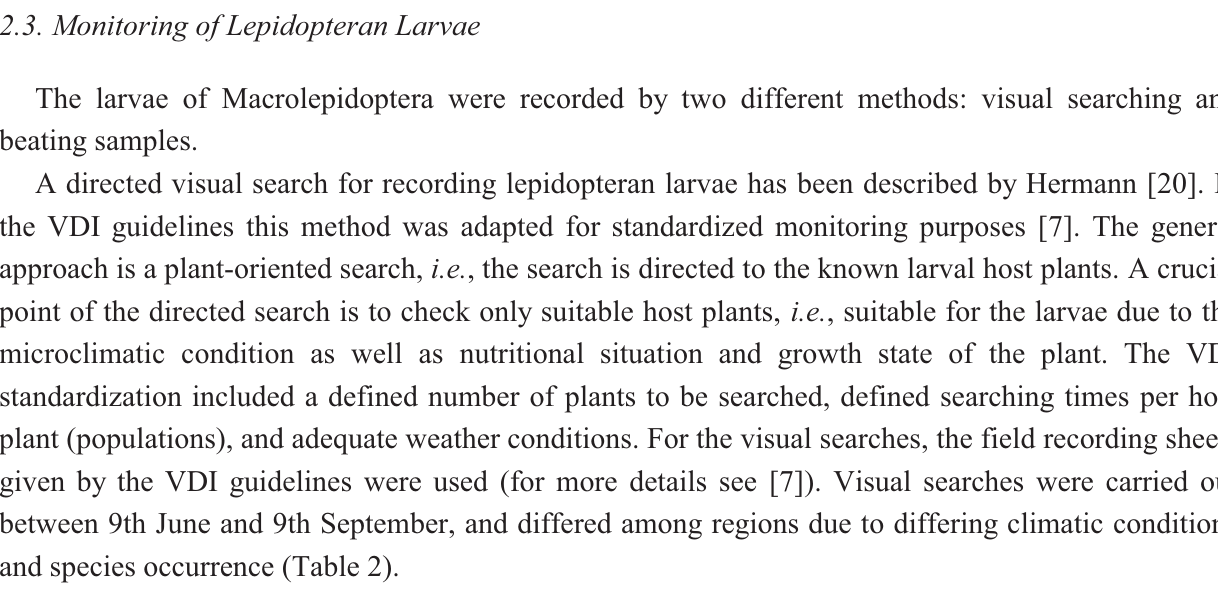
Table 2. Monitoring lepidopteran larvae in three study regions in Germany in 2008: visual search and beating samples. Figures of dates refer to the month of recording, and B = Beginning, M = Mid, E =